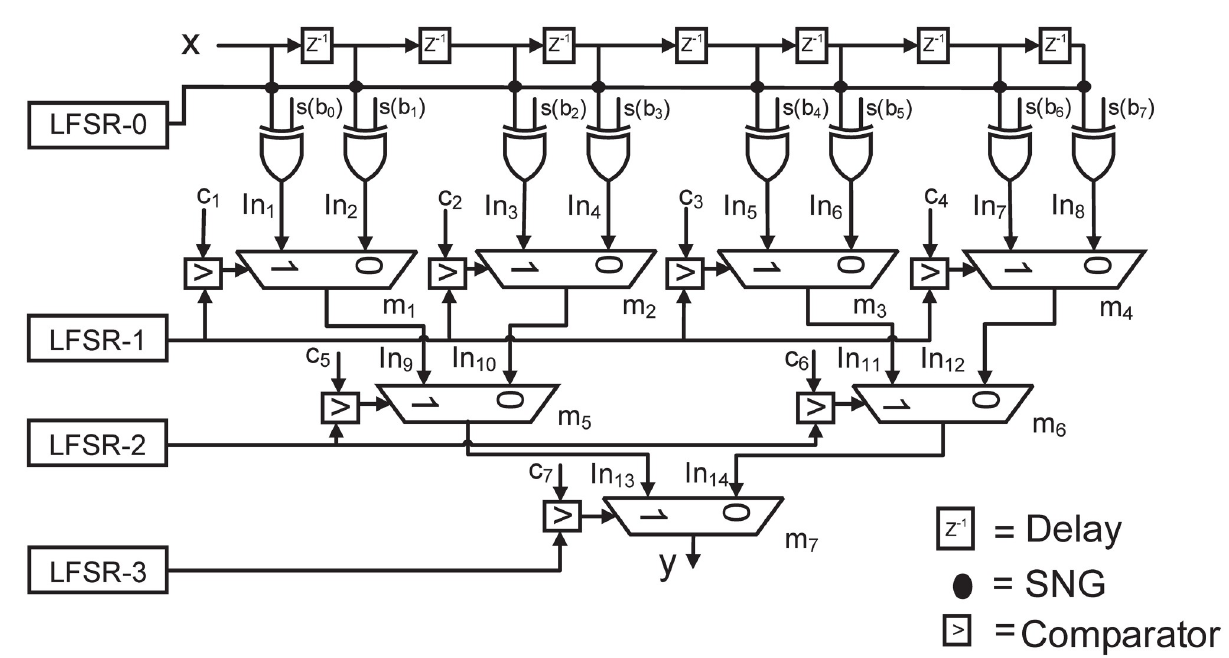
Fig 5. Same-depth-share architecture of 7 th order FIR filter